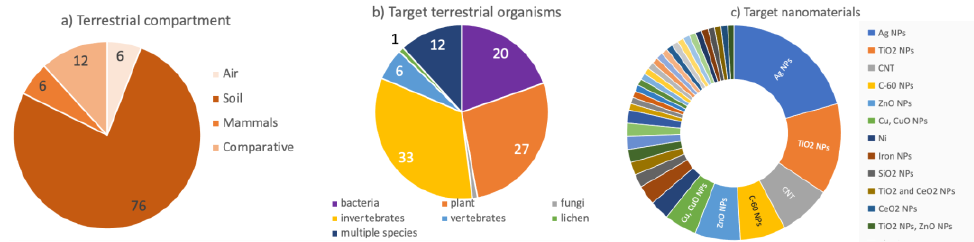
Figure 5. Overview of the selected papers targeting the ecotoxicity of nanomaterials in the terrestrial environment, classified according to ( a ) the different compartments; ( b ) the main target organisms; and ( c ) the selected nanomaterials.